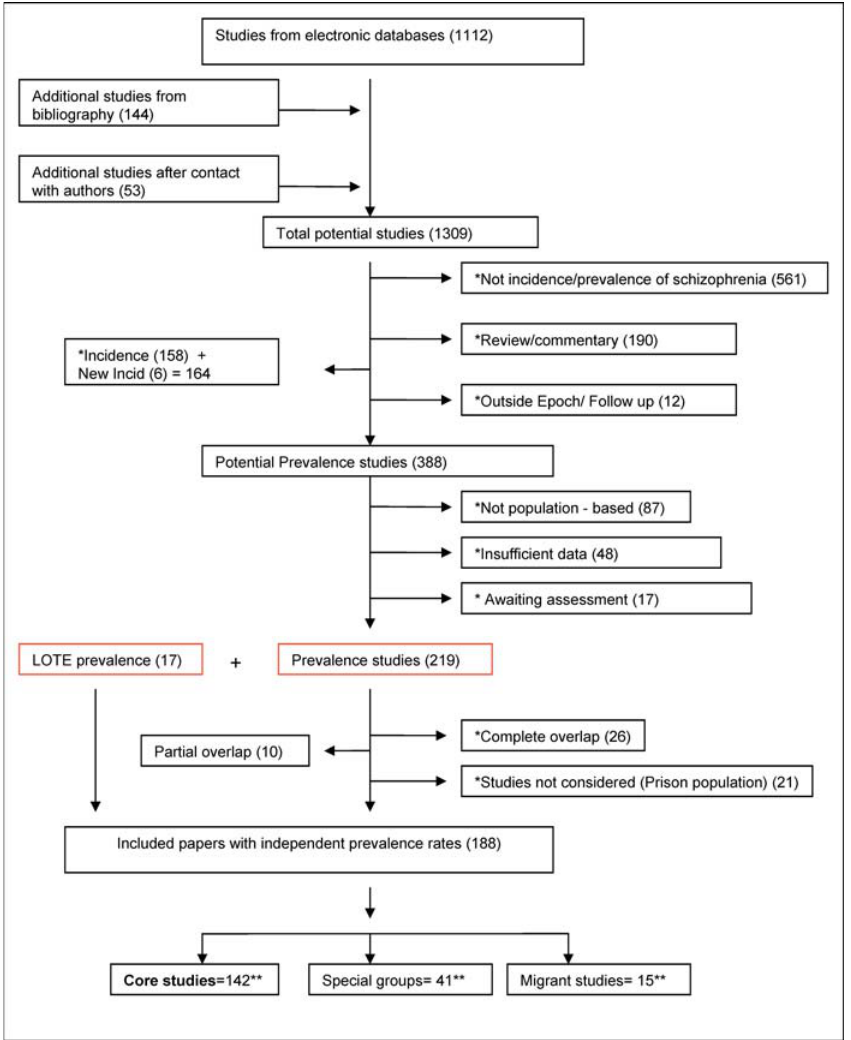
Figure 1. Flow Diagram (Selection Strategy) of Included Studies Double asterisk indicates exclusion categories (number studies excluded in parentheses). Double asterisk indicates numbers that are not mutually exclusive. A few studies provided rates for more than one group (11 studies provided data for both core and migrant [ n = 3] or both core and other special groups [ n = 8]; details in Results). LOTE, language other than English. DOI: 10.1371/journal.pmed.0020141.g001